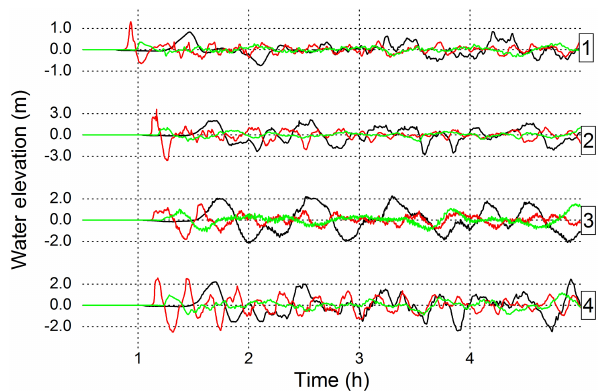
Figure 17. Aggregate field of velocity maxima calculated in the finest grid (40m resolution) assuming mean-sea-level